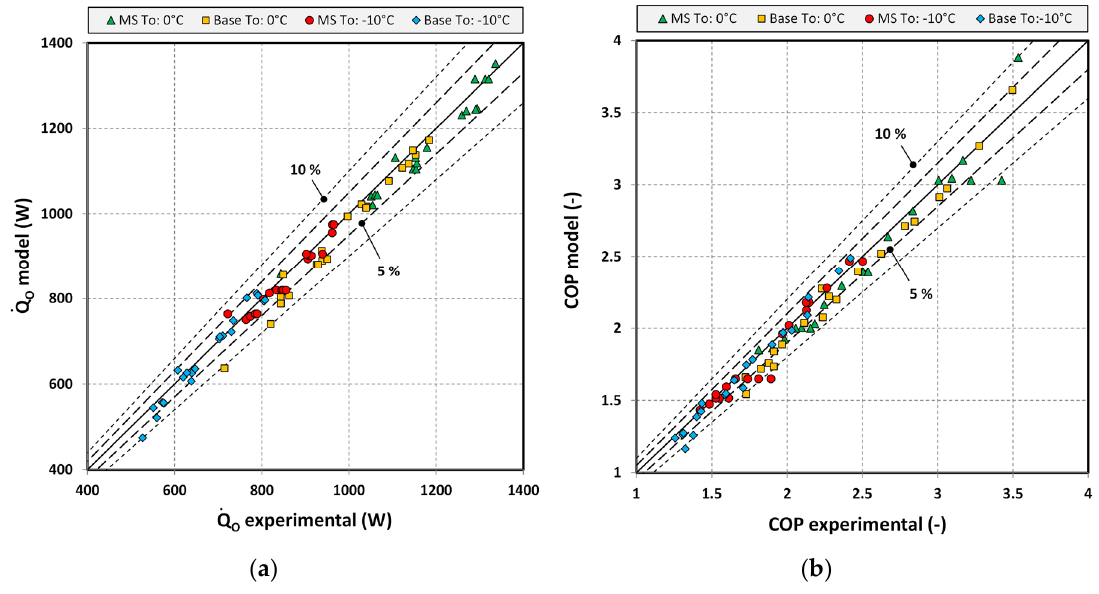
Figure 8. Validation of the computational model using the cooling capacity ( a ) and the COP of the refrigerating plant ( b )with experimental data. refrigerating plant ( b ) with experimental